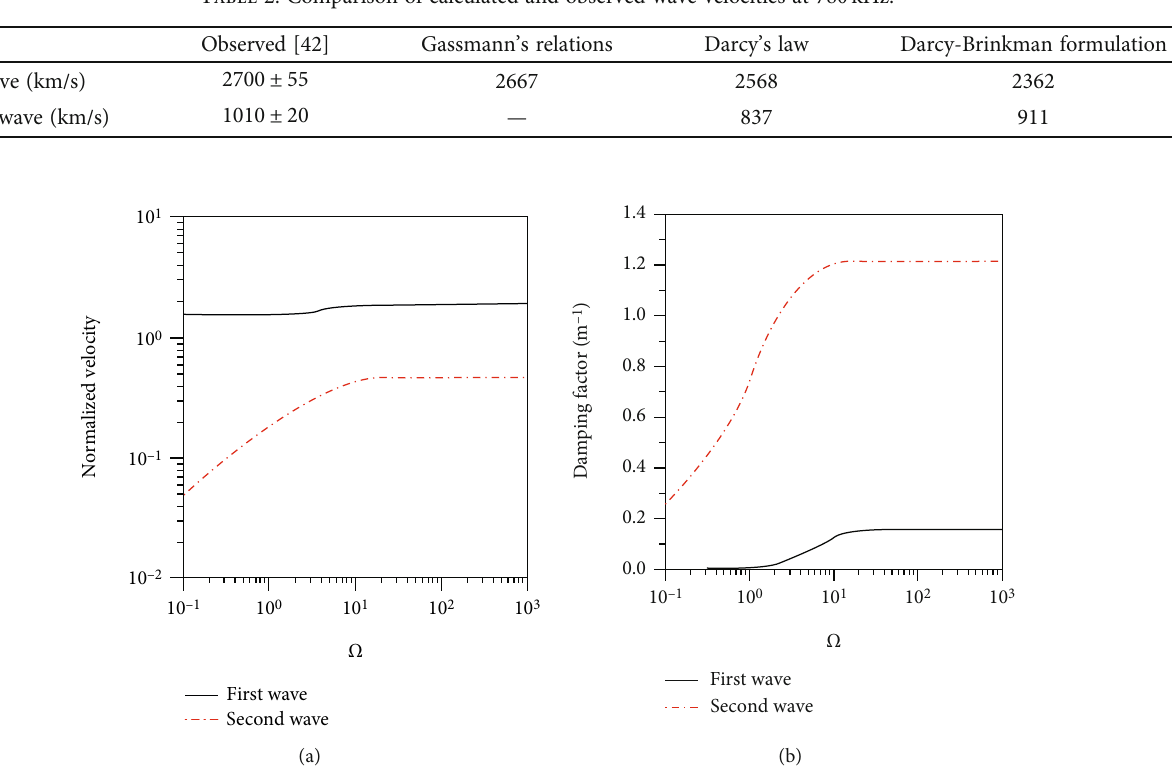
Table 2: Comparison of calculated and observed wave velocities at 780kHz.